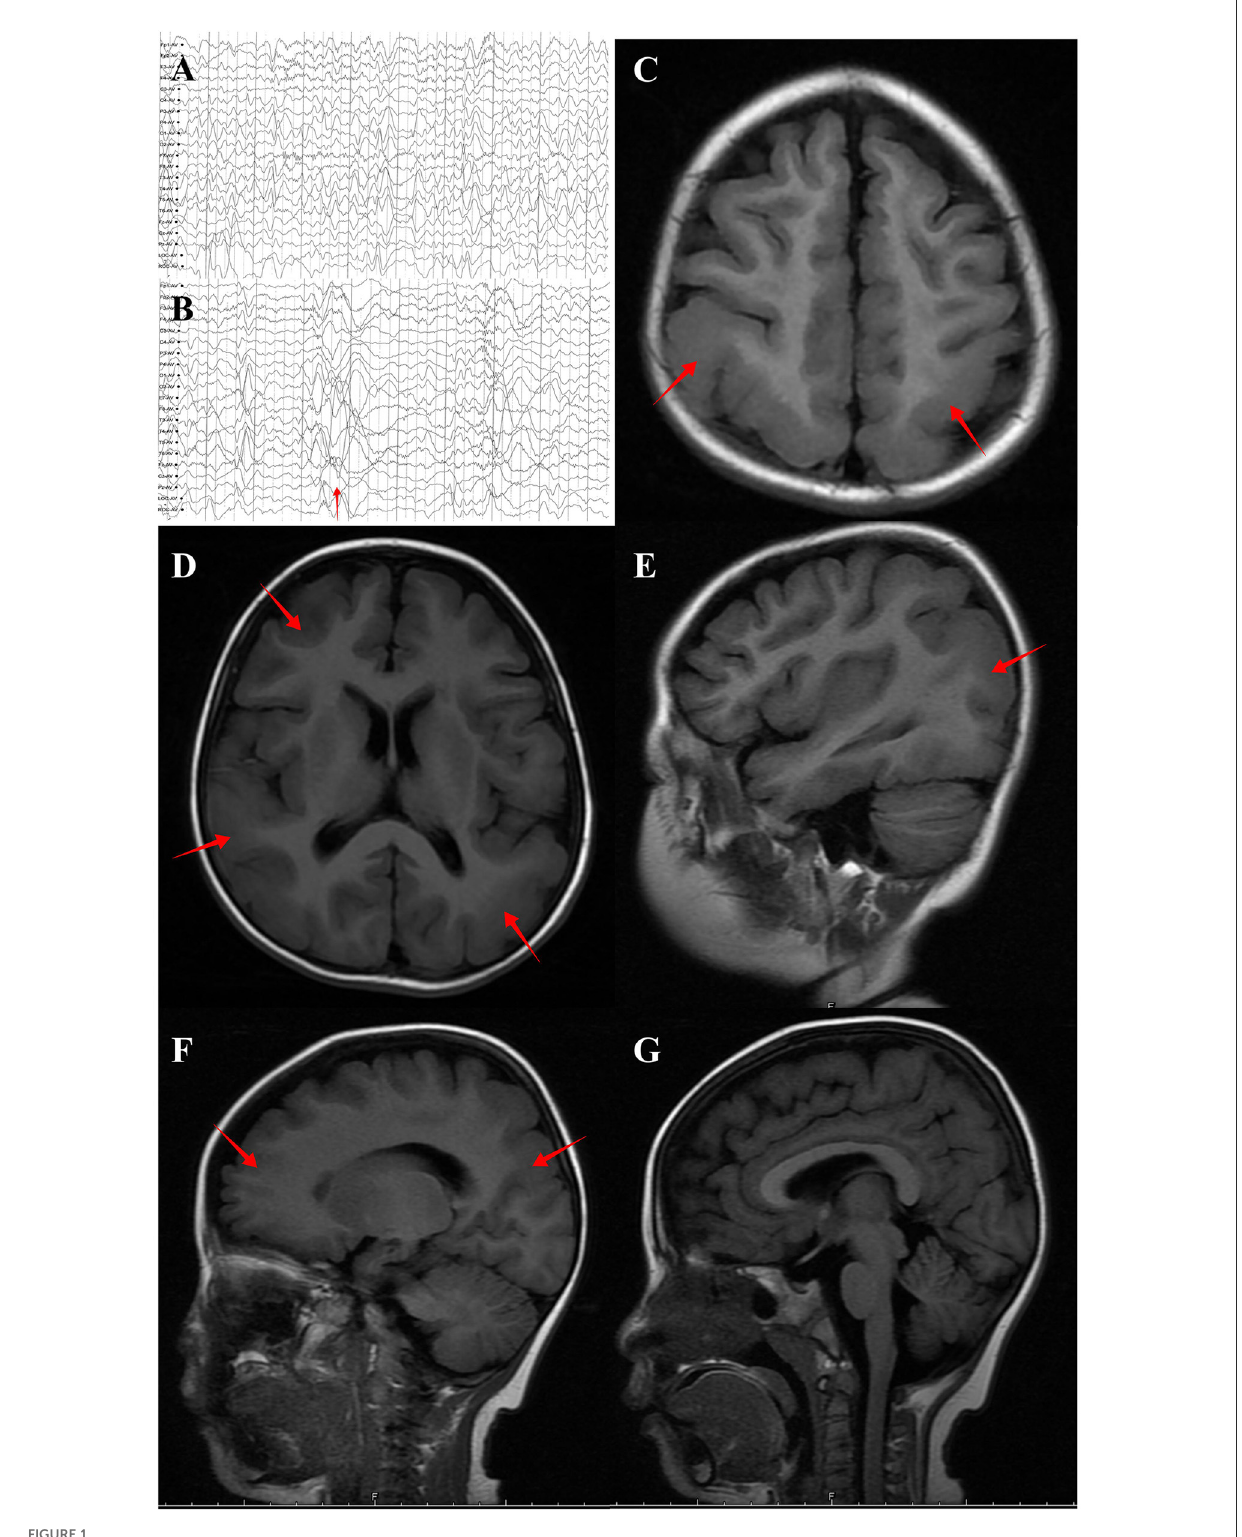
FIGURE1 Brain MRI and EEG of the individual with DYNC1H1 variant p.Arg292Trp. (A) Interictal EEG showed multifocal spike-wave complexes at 2 years old. (B) EEG at spasm onset (2 years old) revealed brief, high γ oscillations combined with slow delta waves (red arrow). (C) (Axial plane, T1 flair), (D) (Axial plane, T1 flair), ( E) (Sagittal plane, T1 flair), (F) (Sagittal plane, T1 flair) and (G) (Sagittal plane, midline, T1 flair). MRI performed at 4 years old and revealed posterior predominant pachygyria (red